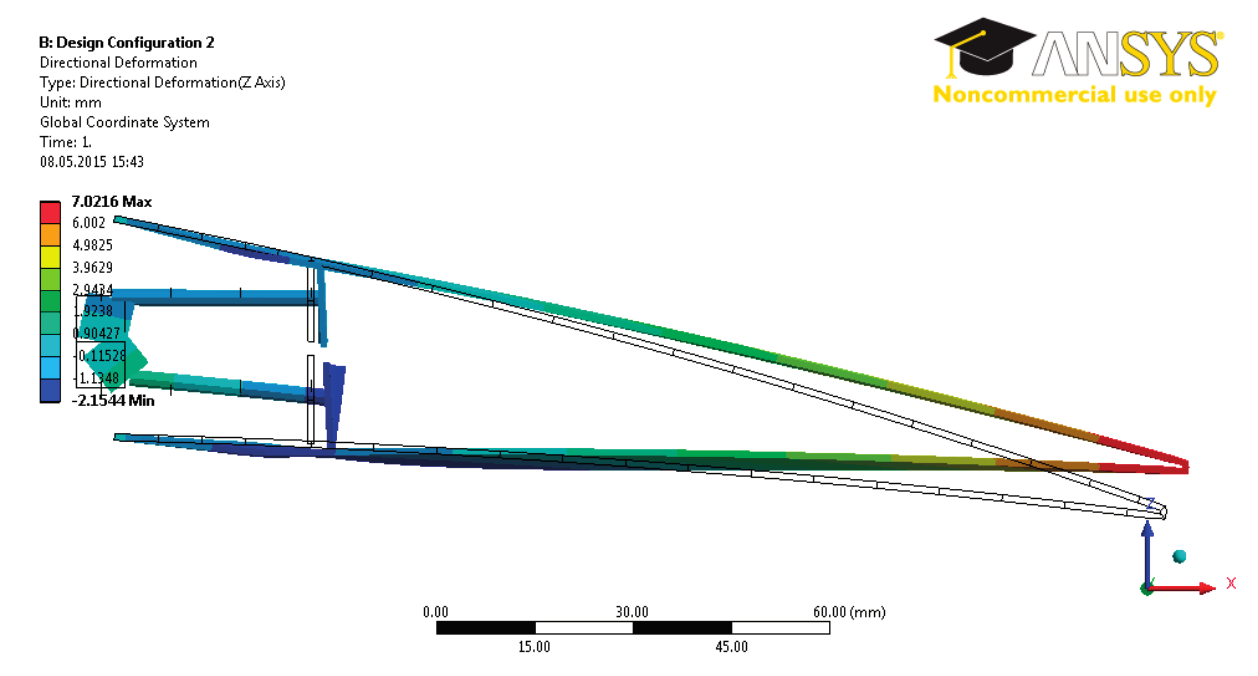
Figure 21. Deformation along Z -axis for design configuration 2.